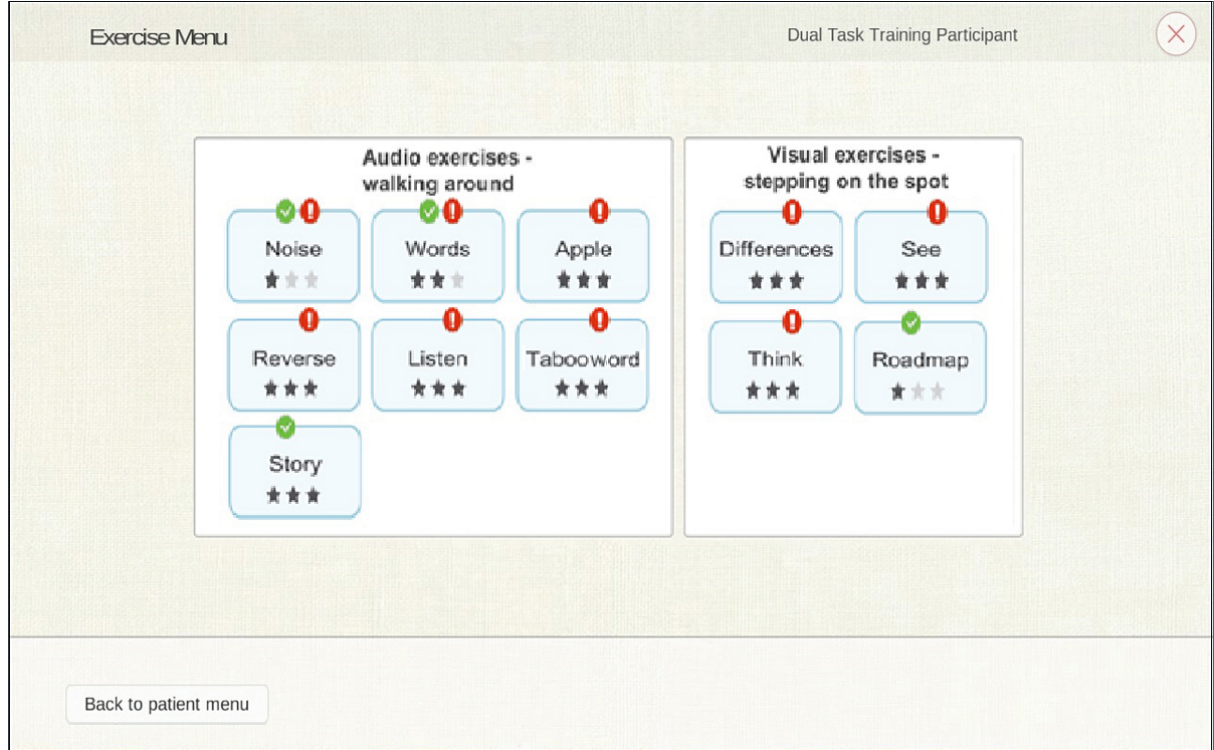
Figure 1. Selection and start of dual-task training. The interface is split into two parts as follows: audio exercises mainly executable by walking around (ie, “Apple,” “Listen,” “Noise,” “Reverse,” “Story,” “Tabooword,” and “Words”) and visual exercises mainly executable by stepping on the spot (ie, “Differences,” “Road map,” “See,” and “Think”). The number of dark stars indicates the exercise difficulty level (three stars indicate level 3). When the exercise is performed in the current session, it is marked with a green check mark. When the exercise is performed in the previous session, it is marked with a red exclamation